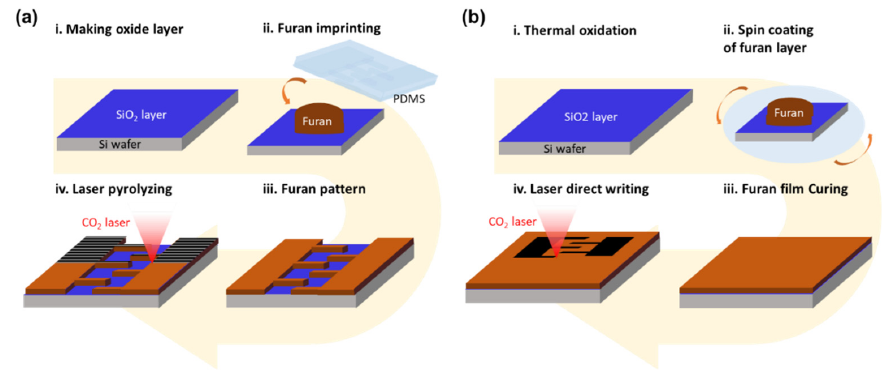
Figure 2. Schematic of furan imprinting and laser pyrolysis process ( a ) and conventional laser direct writing ( b ).